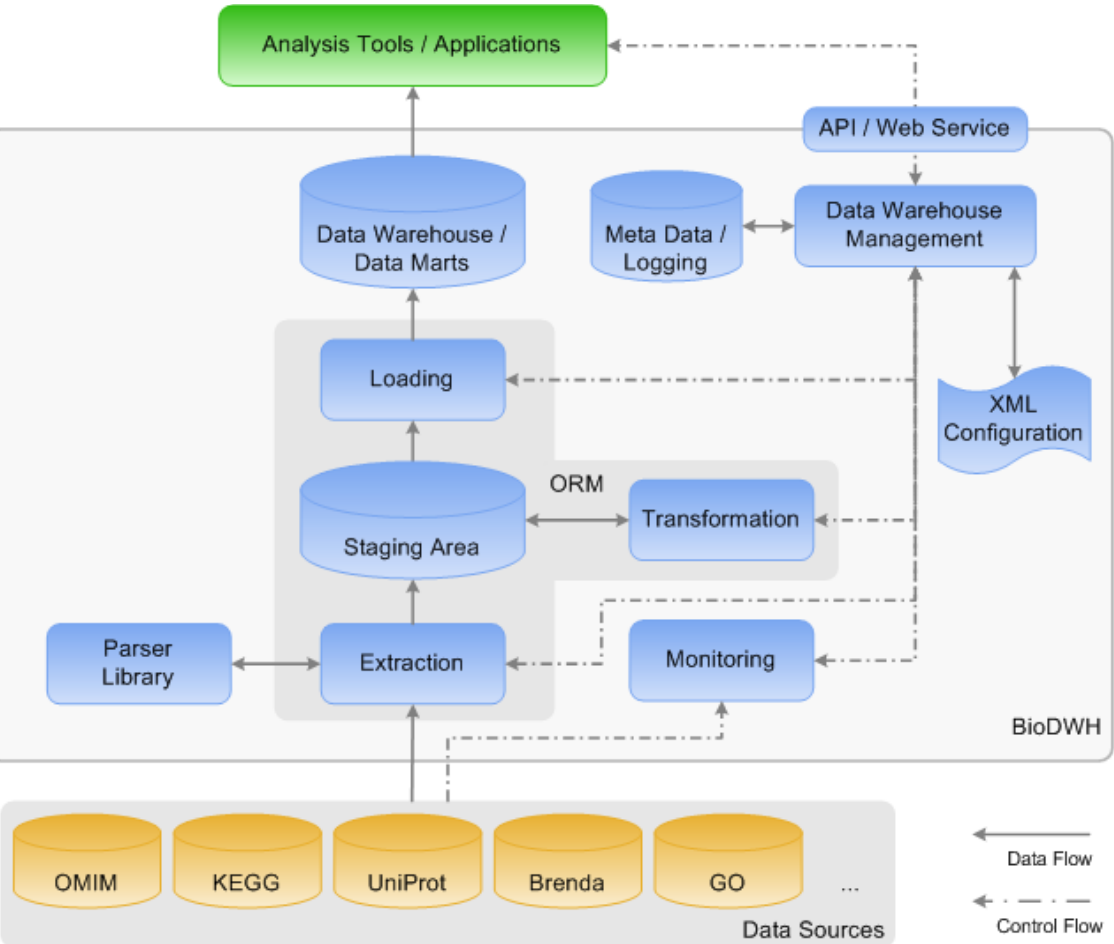
Figure 1: Schematic illustration of the BioDWH system architecture following the general data warehouse